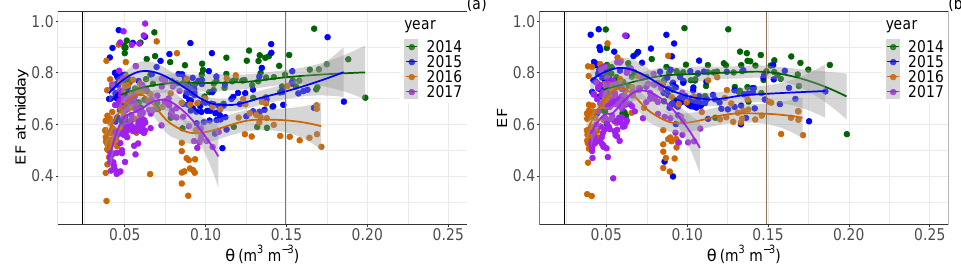
Figure 8. ( a ) Daily averages (considering the hours 8:00–15:00) of Evaporative Fraction (EF = LE / H + LE ) versus daily shallow (10–20 cm of depth) volumetric soil water content θ . ( b ) EF value at local 12:00 versus daily soil water content. Continuous lines in Panels (a,b) represent the wilting point (black) and the field capacity (brown). Regression curves of Panels (a,b) were computed to smooth the EF using the loess filter provided in the “stats” R-package [72]. With the approach described by